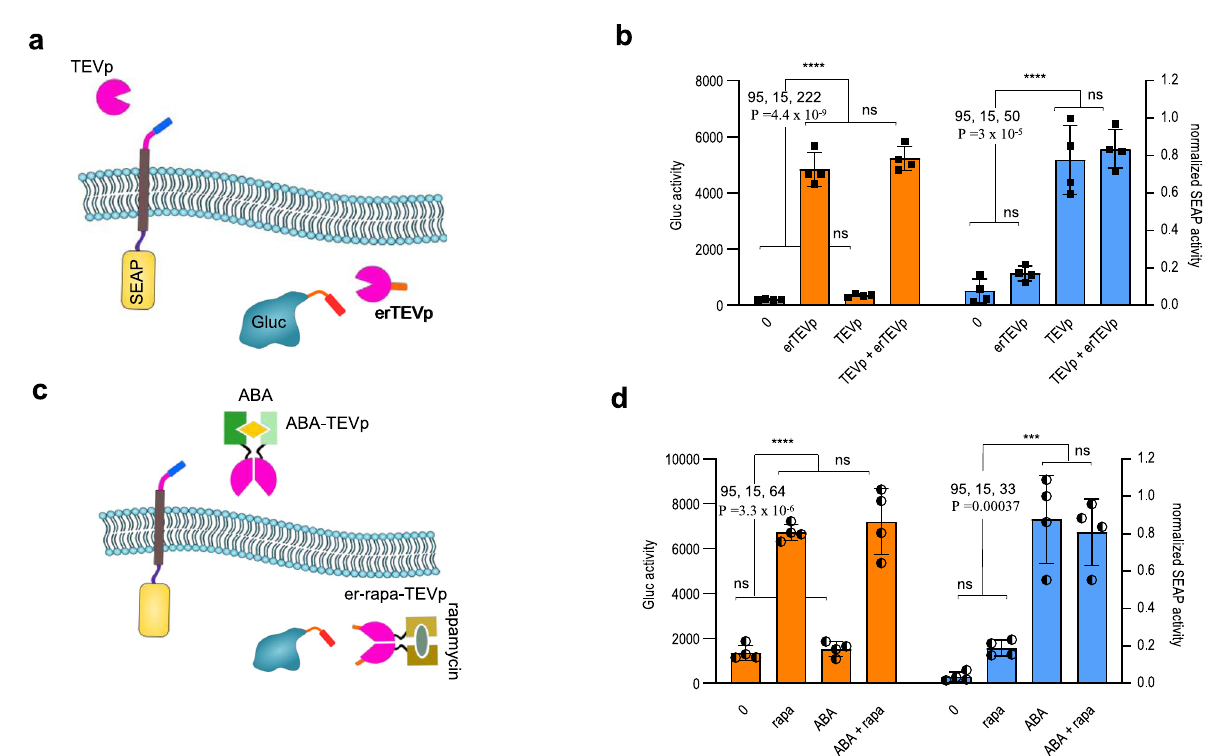
Fig. 4 Orthogonality of the lumER and membER system. a Cells were co-transfected with membER system, featuring SEAP as a reporter, and lumER system, featuring a Gluc reporter. b Gluc (orange) and SEAP (blue) activity was measured in the media after the addition of TEVp and erTEVp. c Design of the inducible and orthogonal system. aba-TEVp and er-rapa-TEVp were co-transfected with the membER-SEAP and lumER-Gluc constructs. d the systems were tested with inducible proteases. aba-TEVp was used for secretion with the membER (blue) and er-rapa-TEVp was used for the lumER system (orange). Values are the mean of four cell cultures ± s.d. and are representative of two independent experiments. Signi fi cance was tested by one-way analysis of variance (ANOVA) with Tukey ’ s comparison between indicated states (values of con fi dence intervals, degrees of freedom, F and P are indicated). * P < 0.05, ** P < 0.01, *** P < 0.001, **** P < 0.0001. Source data are provided as a Source Data fi